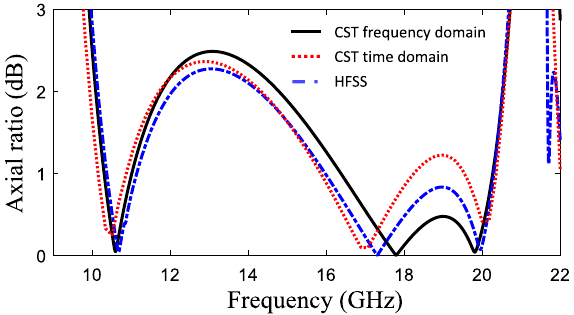
Figure 9. Axial ratio of the designed polarization converter